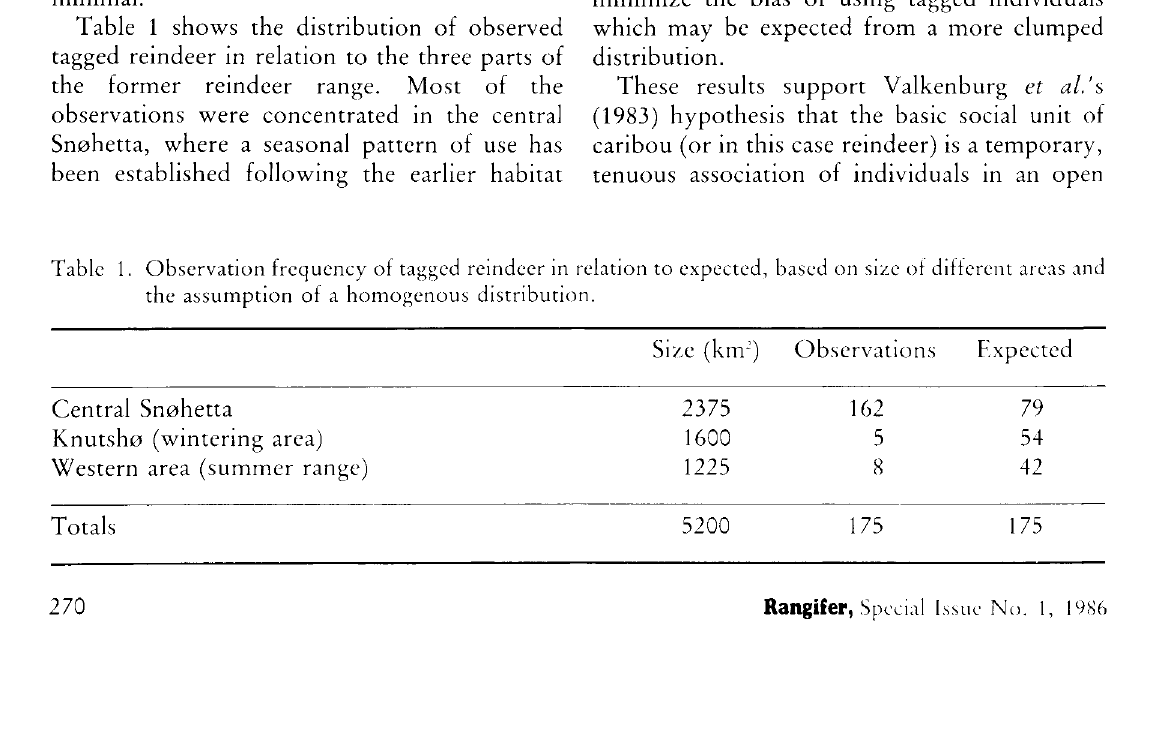
Table 1. Observation frequency of tagged reindeer in relation to expected, based on size of different areas and the assumption of a homogenous